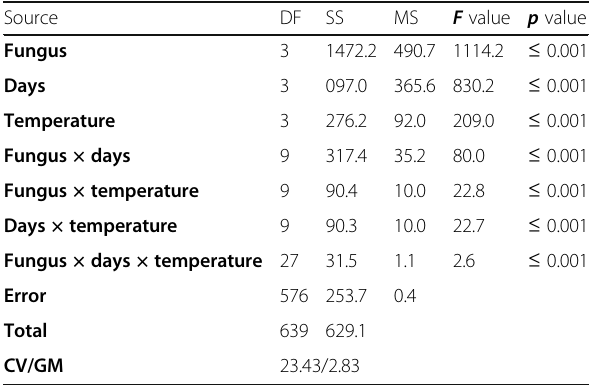
Table 3 Factorial analysis of variance of mortality of Bemisia tabaci bioassay with the filtrate of two strains of Beauveria